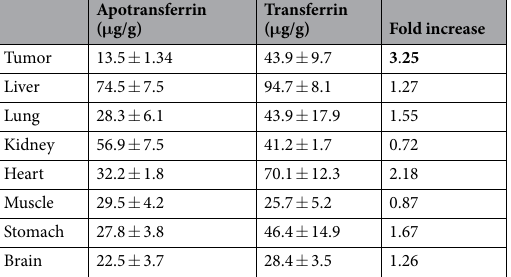
Table 1. Distribution of ferric ion in each organ after single i . v . injection of transferrin into tumor-bearing mice. The ferric ion in each organ of the tumor-bearing mice was quantitated by the ICP-MS method after complete acid lysis of the organs. The values represent the mean ± standard deviation ( n = 6).